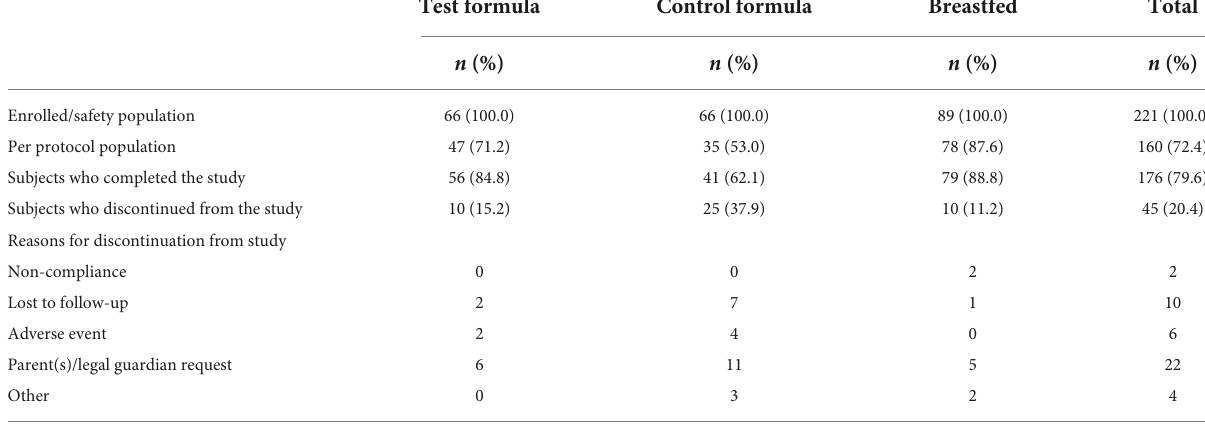
TABLE 2 Subject disposition.